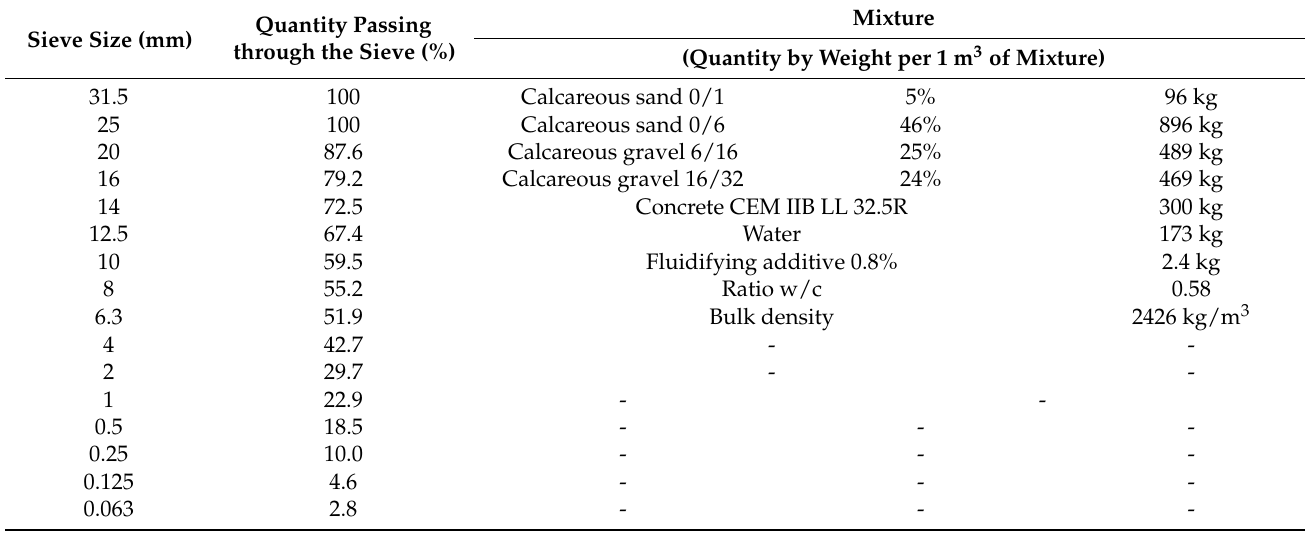
Table 1. Aggregate mixture with calcareous gravel. On the left side, the quantity passing through the sieve expressed in percentage of the calcareous gravel and the sieve size used; on the right side, the component used for the mixture. Sieve Size